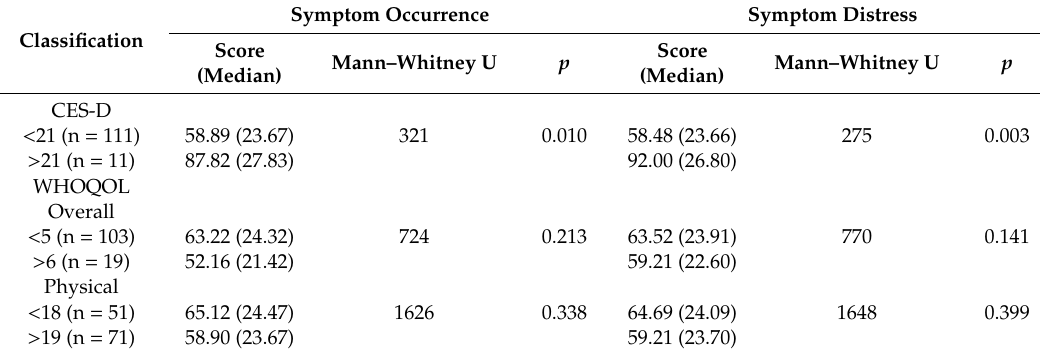
Table 3. Comparison of median symptom occurrence and symptom distress scores among kidney recipients according to depression and quality of life